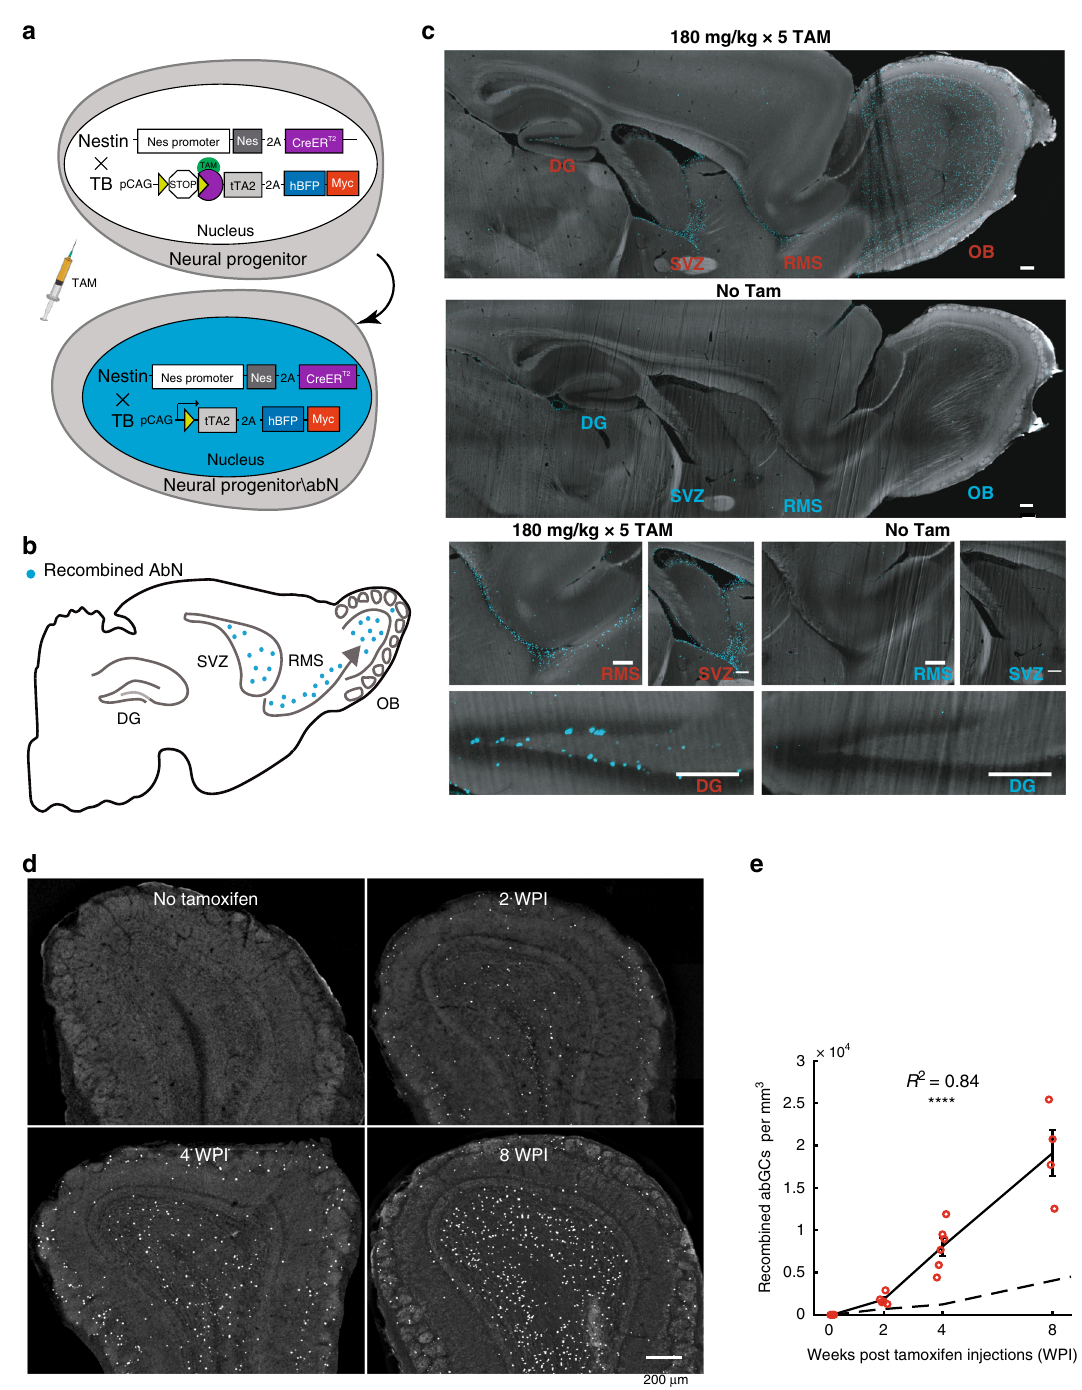
(Supplementary Fig. 1A – D) at different time points post virus injection. Speci fi cally, CNO injection into Nest Cre/ + x TB + mice that were exposed to odors signi fi cantly reduced the number and intensity of c-Fos in genetically tagged abGCs expressing DREADDs, as compared to abGCs that did not express DREADDs in the same mice ( N = 3 mice;